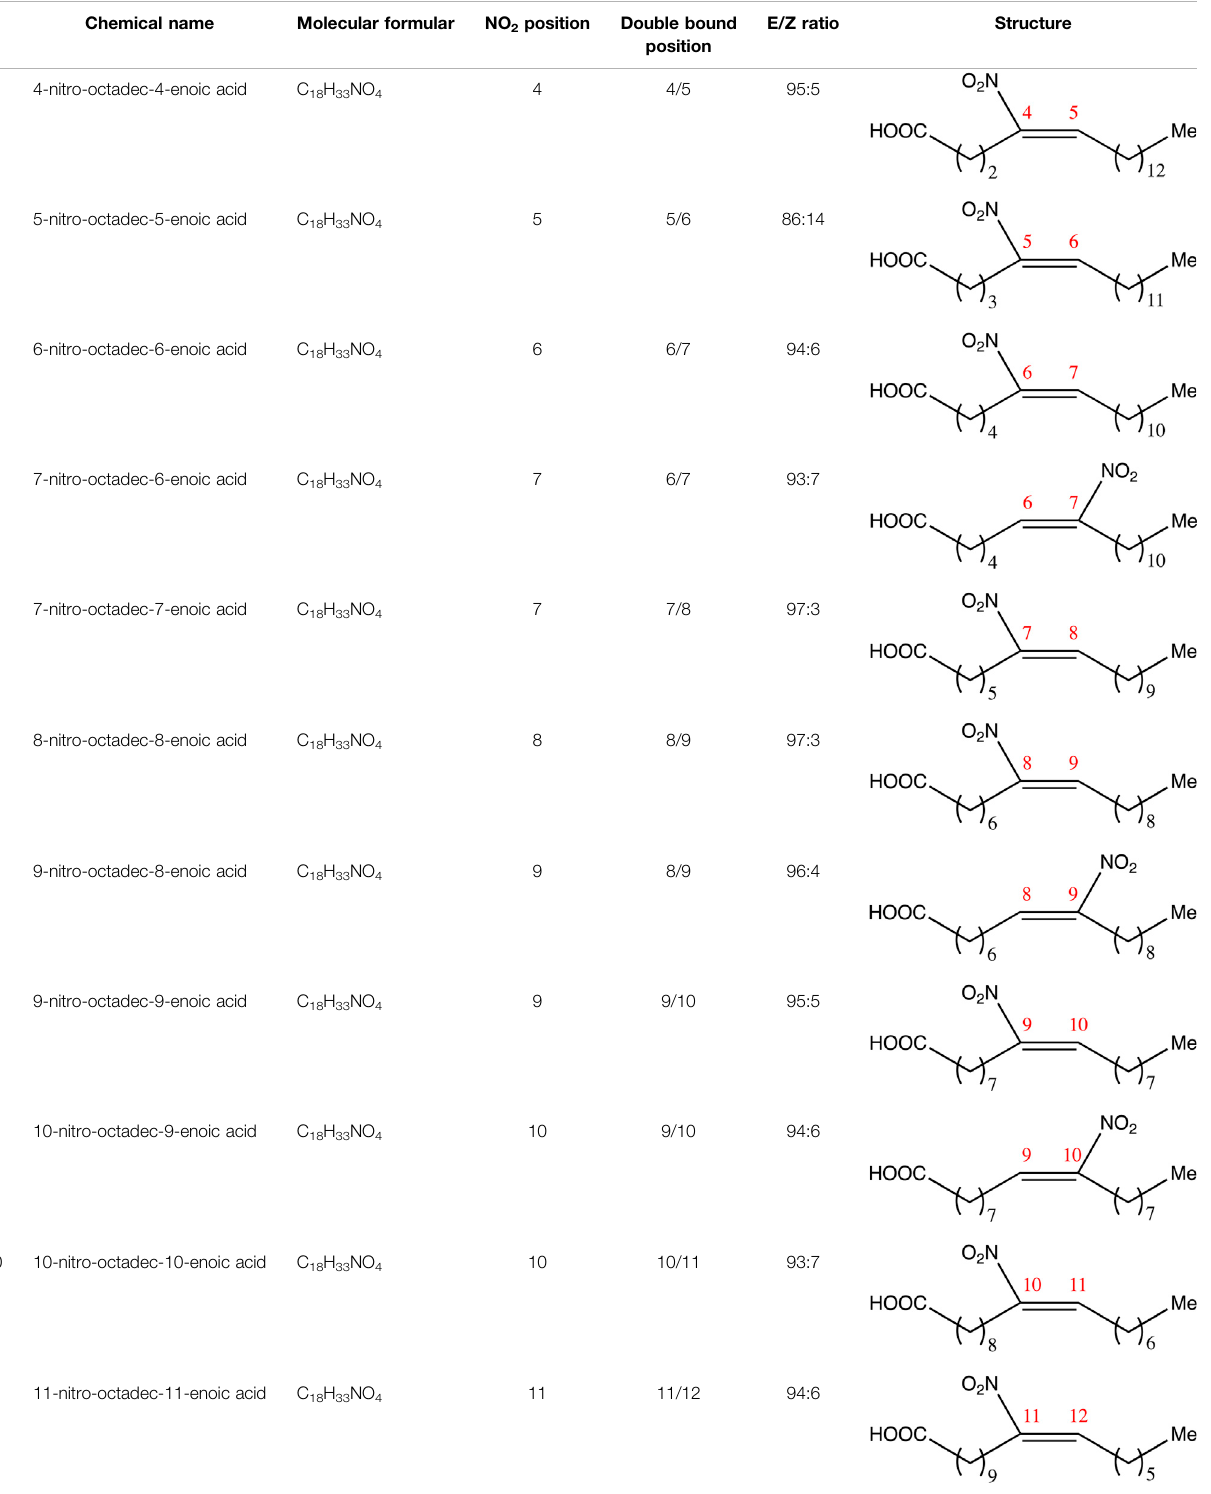
TABLE 1 | Chemical compounds with 18 carbon atoms derived from the chemical lead